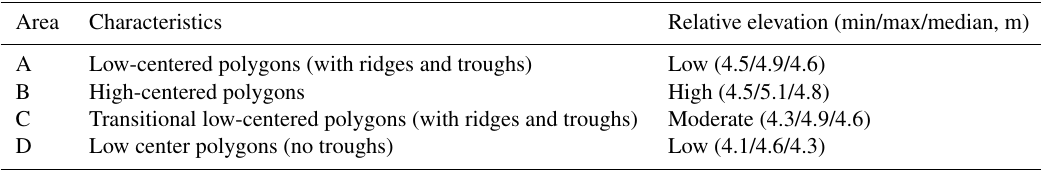
Table 1. Areas A, B, C, D polygonal features and environmental characteristics. Area Characteristics A Low-centered polygons (with ridges and